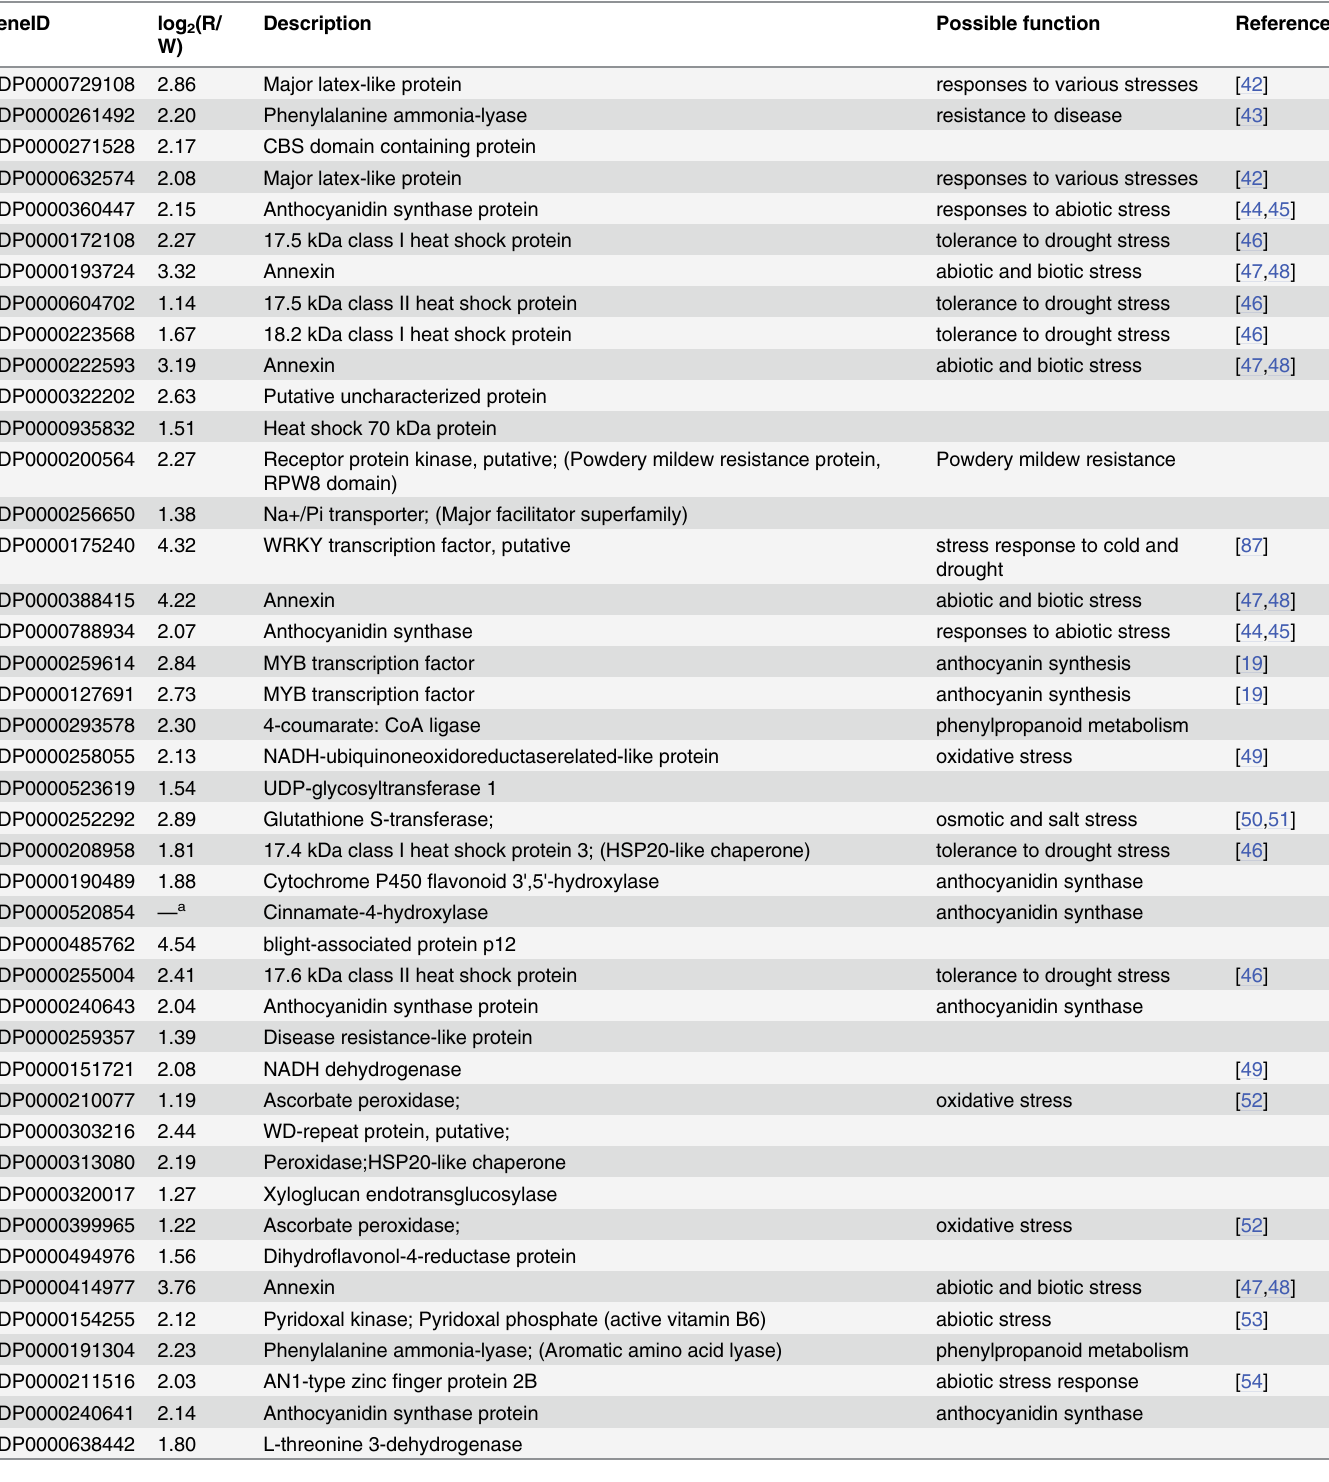
Table 3. Up-regulated genes related to stress responses between red- and white-fleshed apples. GeneID log 2 (R/